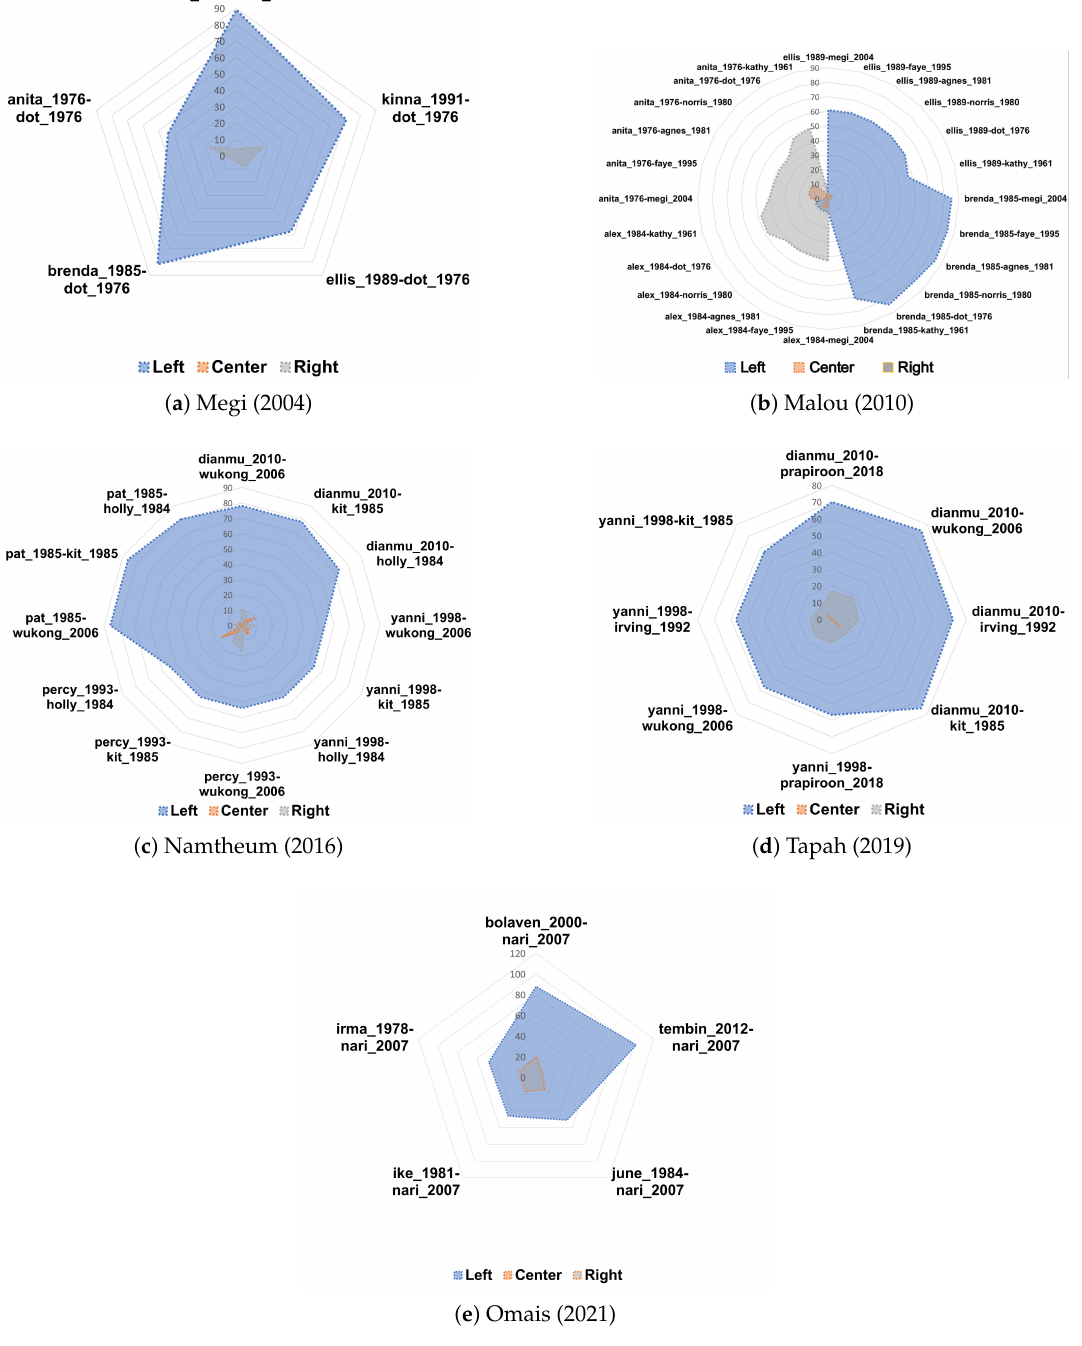
Figure 8. Results of k-NN classification for the meridional component: ( a ) Megi 2004, ( b ) Malou 2010,